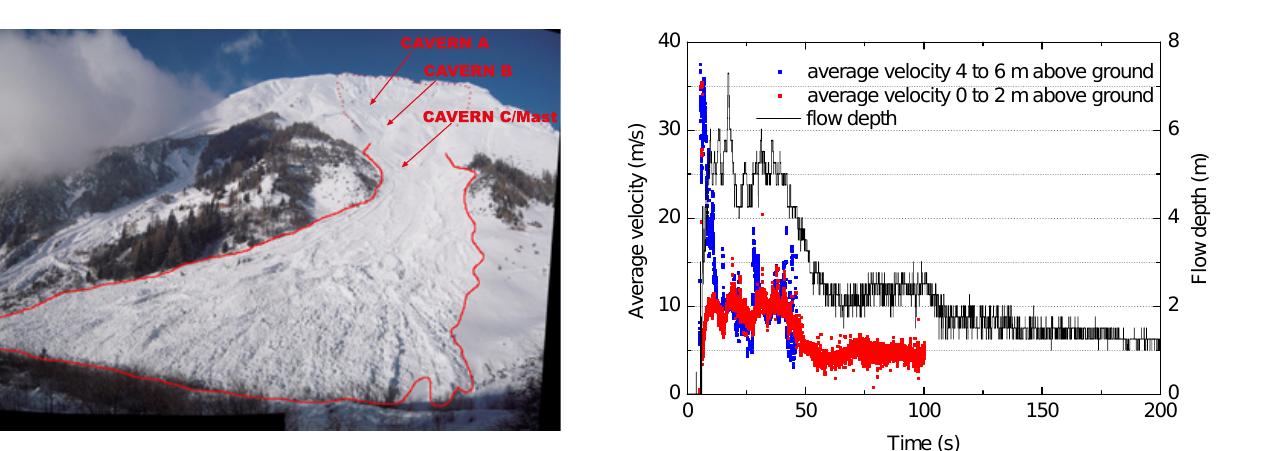
Fig. 4. Flow depth and average velocities measured at the pylon, close to cavern C. The avalanche was characterized by a fast diluted front moving at 35ms − 1 (blue dots) and a slow large dense core moving at about 10ms − 1 (red dots). Undulations in velocity and flow depth indicate that the flow was characterized by successive surges. This large avalanche had maximum flow depths up to 6m to 7m at the